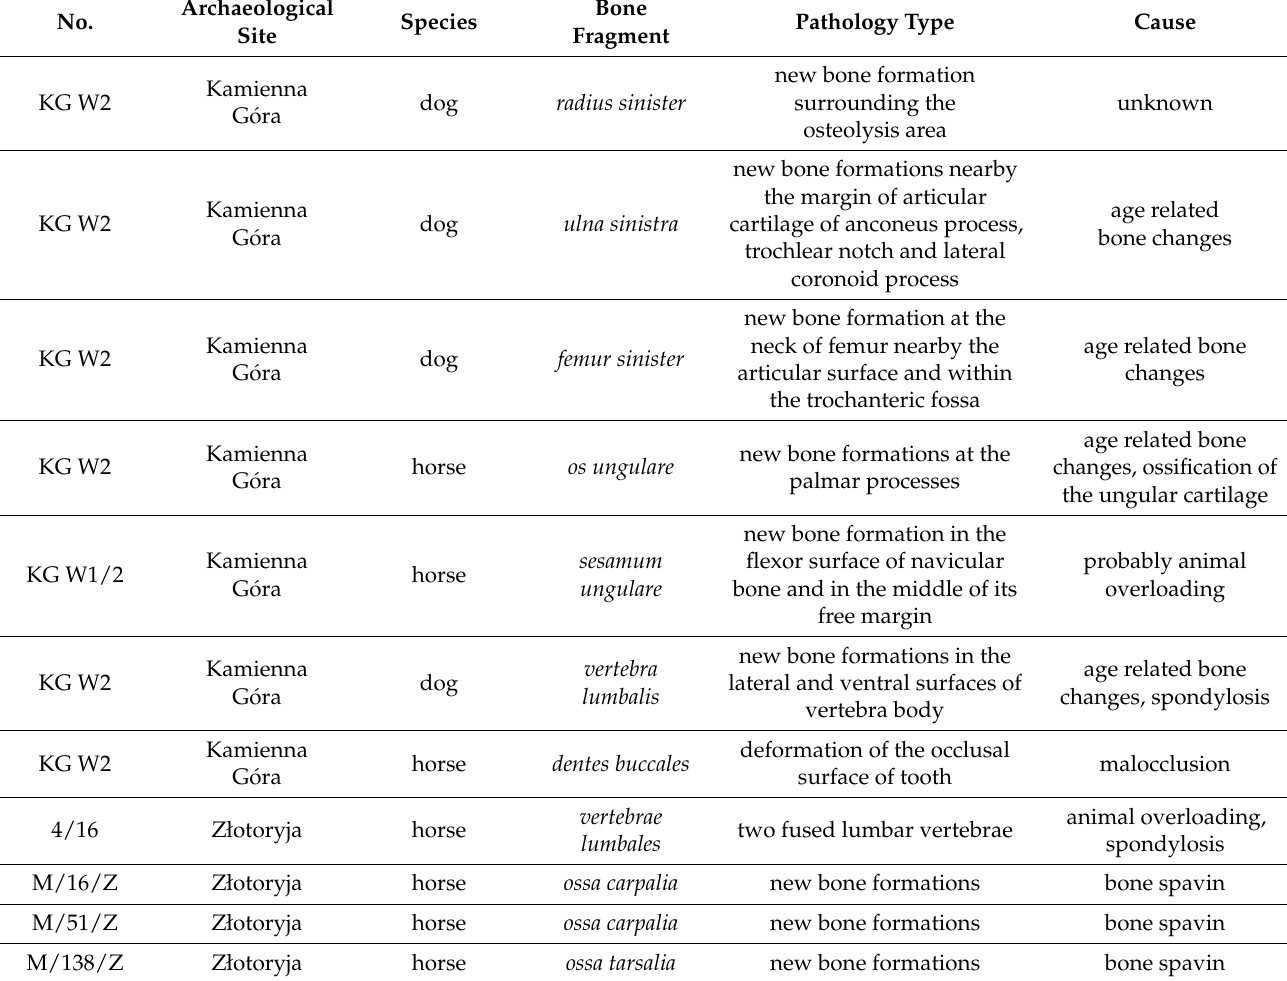
Table 9. Summary of bone pathologies caused by many different